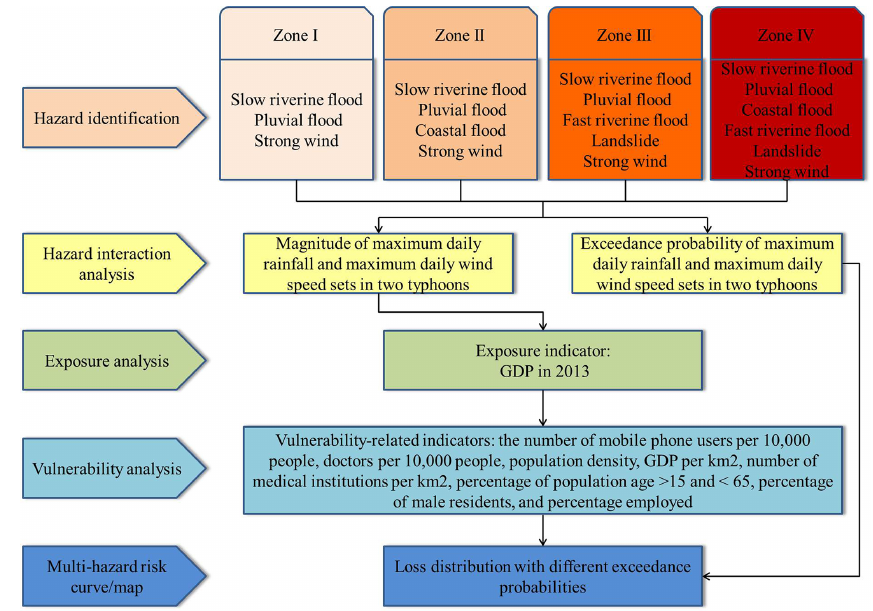
Figure 6. Basic framework of multi-hazard risk assessment for two consecutive typhoons in the Yangtze River